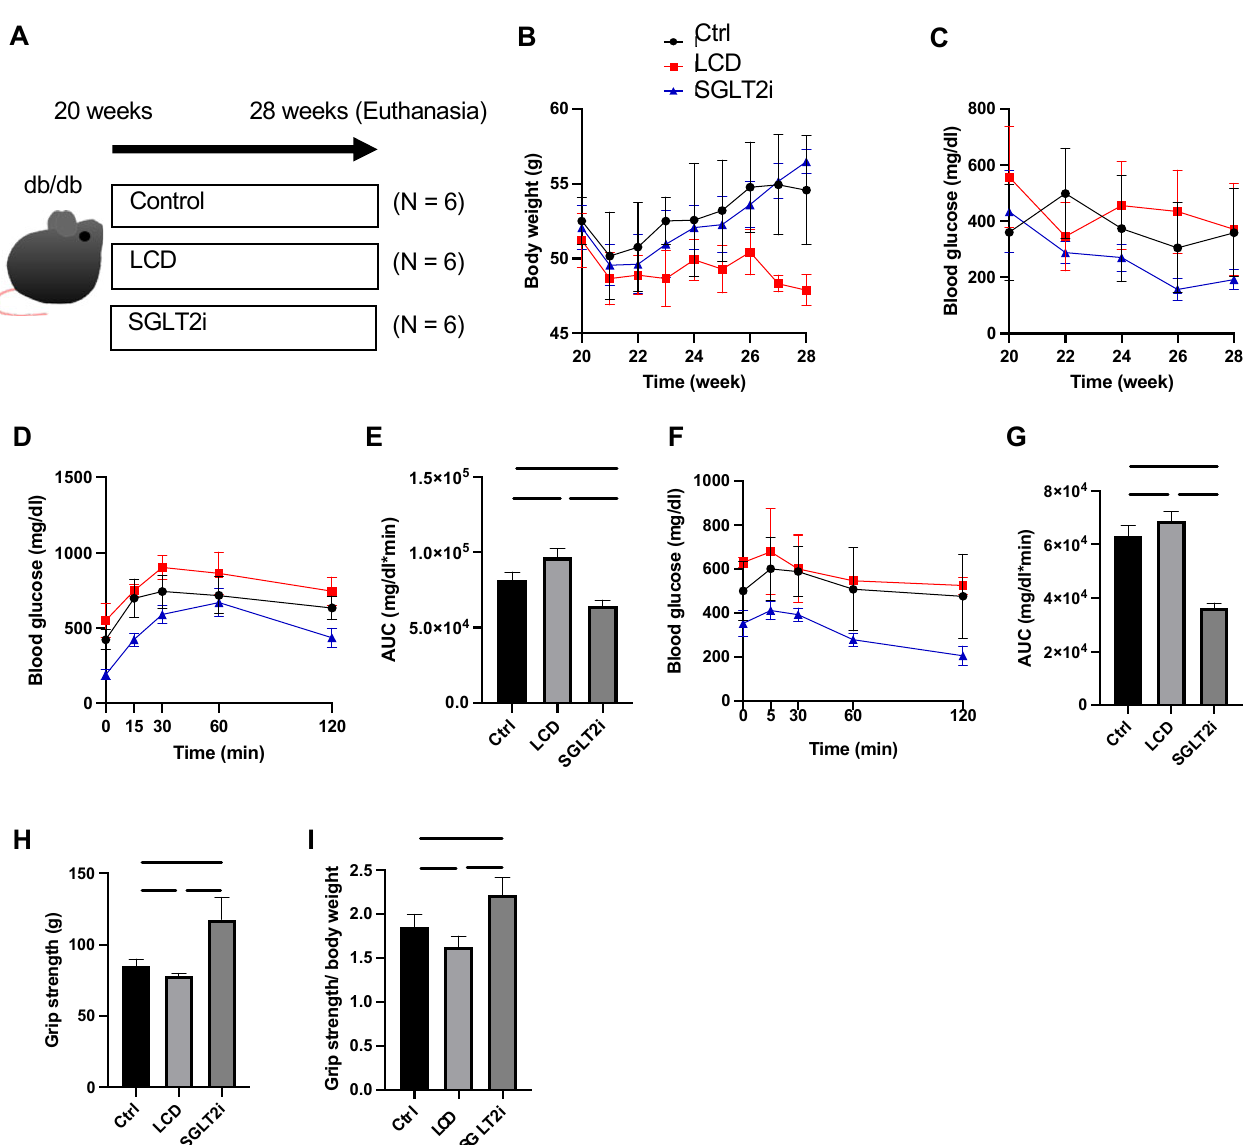
Figure 1. Low-carbohydrate diet (LCD) aggravated glucose impairment and reduced muscle strength, Figure 1. Low ‐ carbohydrate diet (LCD) aggravated glucose impairment and reduced muscle whereas sodium-glucose co-transporter-2 inhibitor (SGLT2i) improved them. ( A ) Overview of the feeding and euthanasia protocol. ( B ) Body weight changes. ( C ) Fasting blood glucose changes. ( D , E ) Intraperitoneal glucose tolerance test (iPGTT) results and the area under the curve (AUC) of iPGTT. ( F , G ) Insulin tolerance test (ITT) results and the AUC of ITT. Luseogliflozin improved their impaired glucose tolerance. ( H , I ) Absolute and relative grip strength. Data are mean ± standard deviation (SD). One-way analysis of variance (ANOVA) was conducted for statistical analysis. 2.2. Fasting Blood Glucose Measurement and Glucose Tolerance